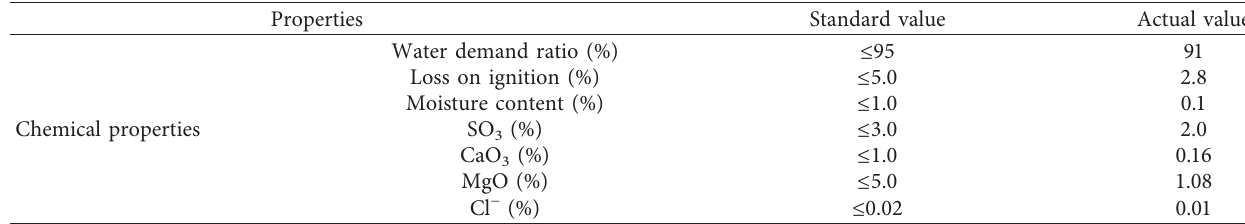
Table 3: Chemical properties of fly ash.